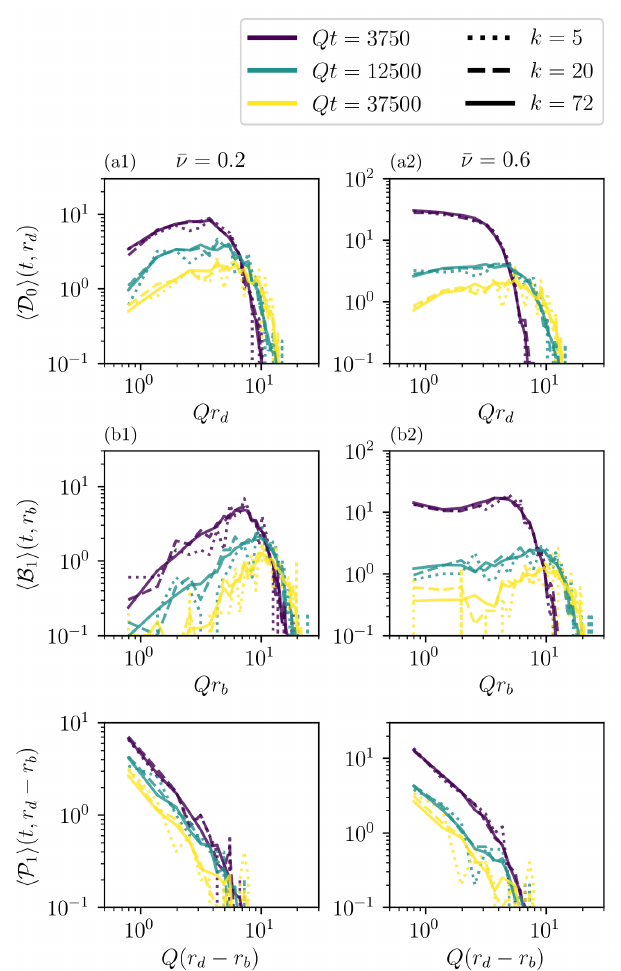
Figure 16: Birth and death radii distributions and persistence distributions in the infrared varying with time, displayed for ¯ ν -values and numbers of samples to average, k , as